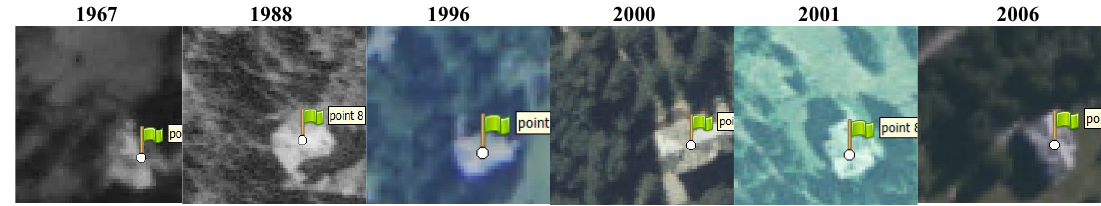
Figure 3. Images of a GCP tracked in multiple photos across different epochs.